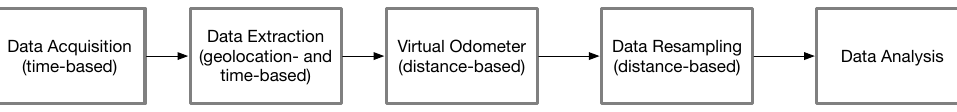
Figure 3. The data preparation flow used for this